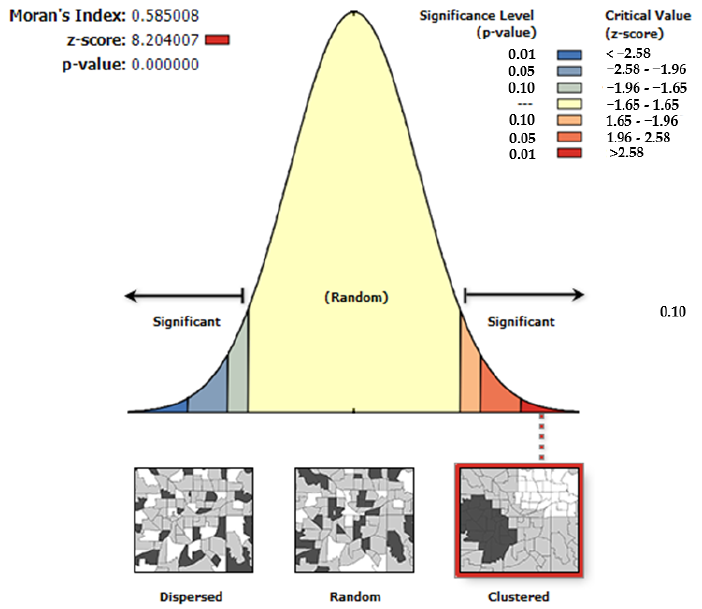
Figure A3. Scatter chart with fitting confidence interval.